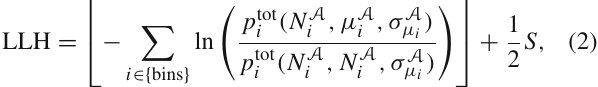
and zenith angle is chosen to be uniform in log cos (θ reco ν